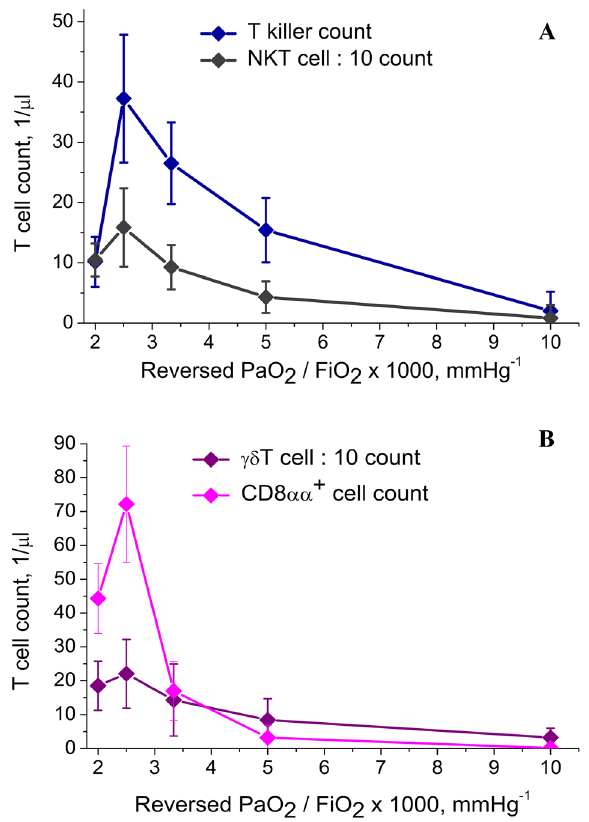
CD8αα+ cell counts dependency on PaO 2 /FiO 2 ratio. Created in OriginPro ver. 9.2.196, https:// www. origi nlab.